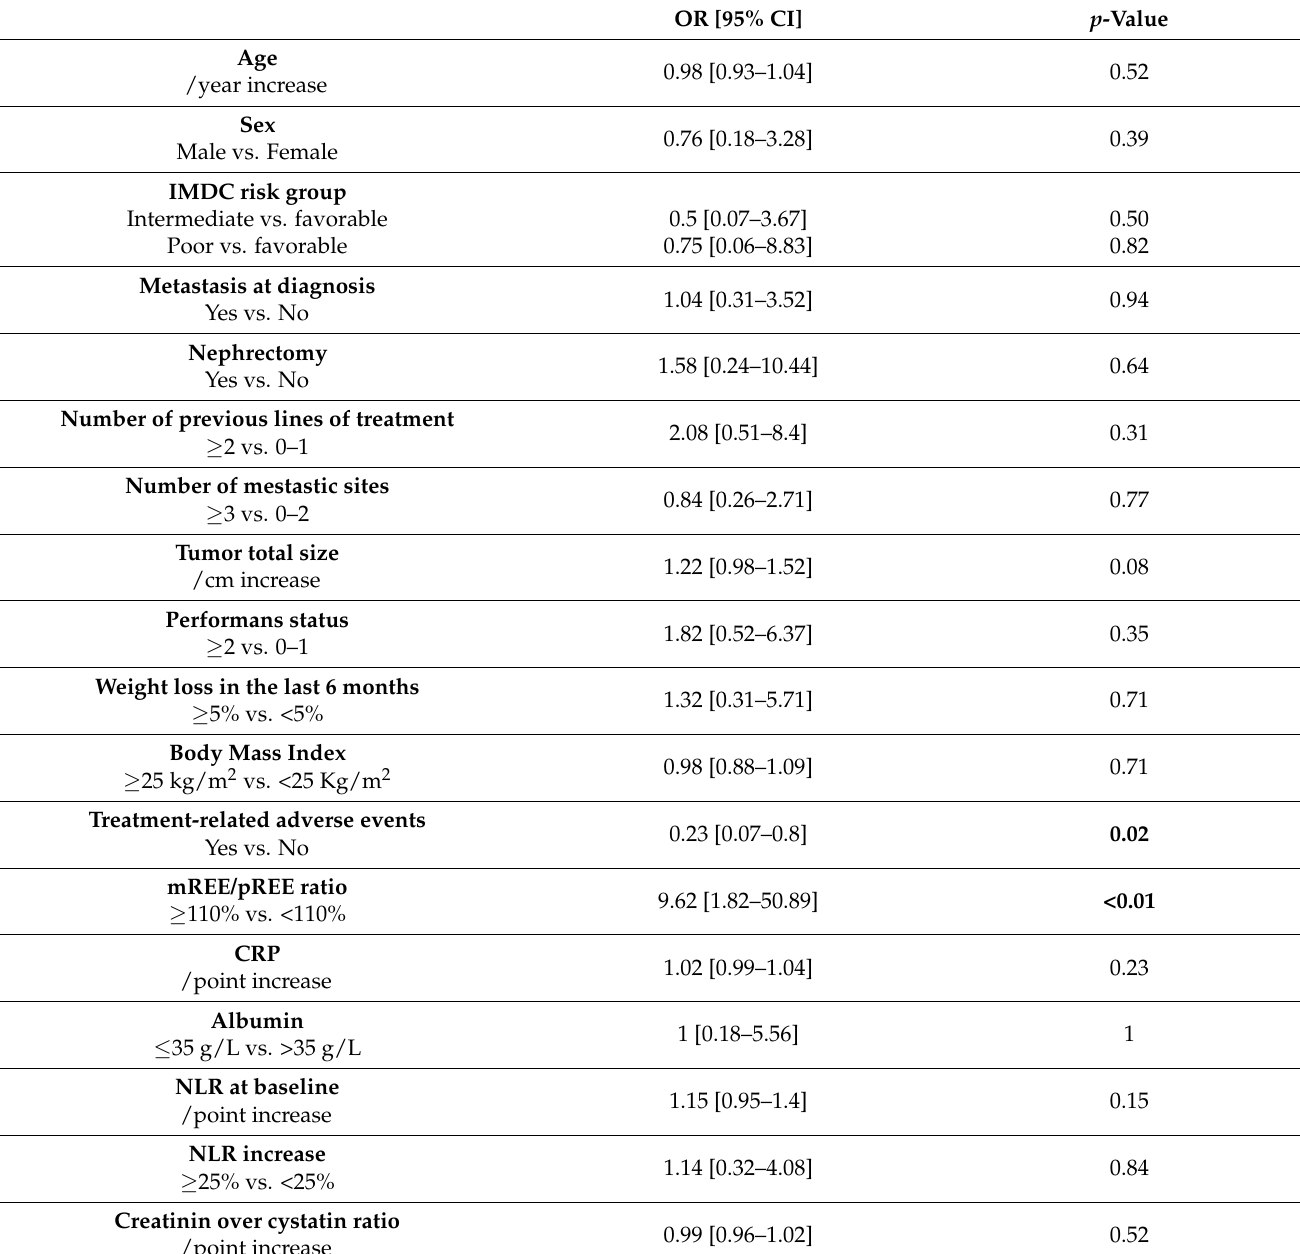
Table 2. Univariate analysis of 6-month progression-free